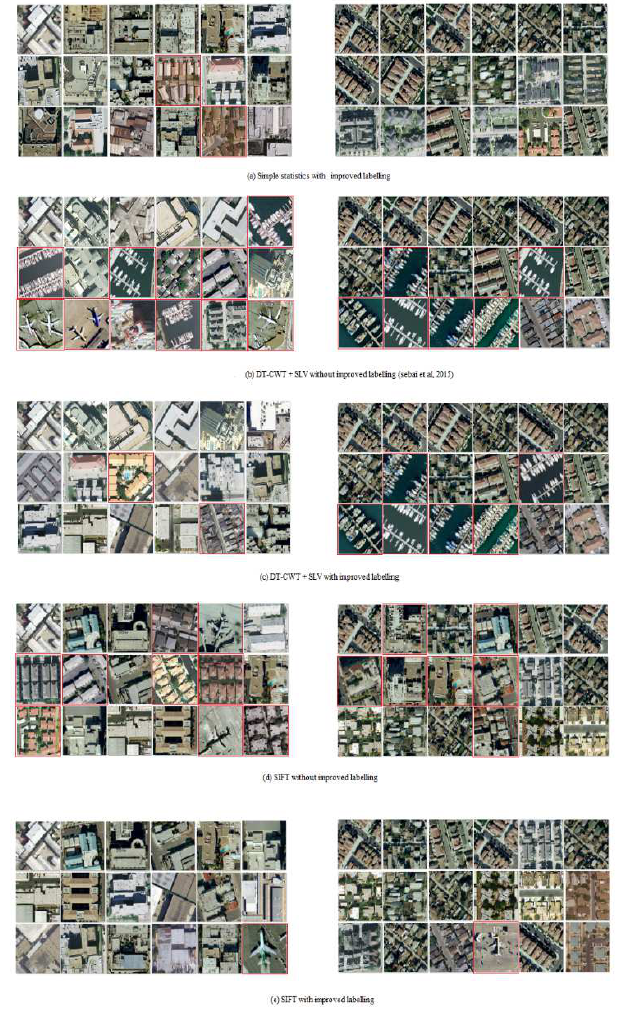
Figure 21. Examples of images retrieved a) simple